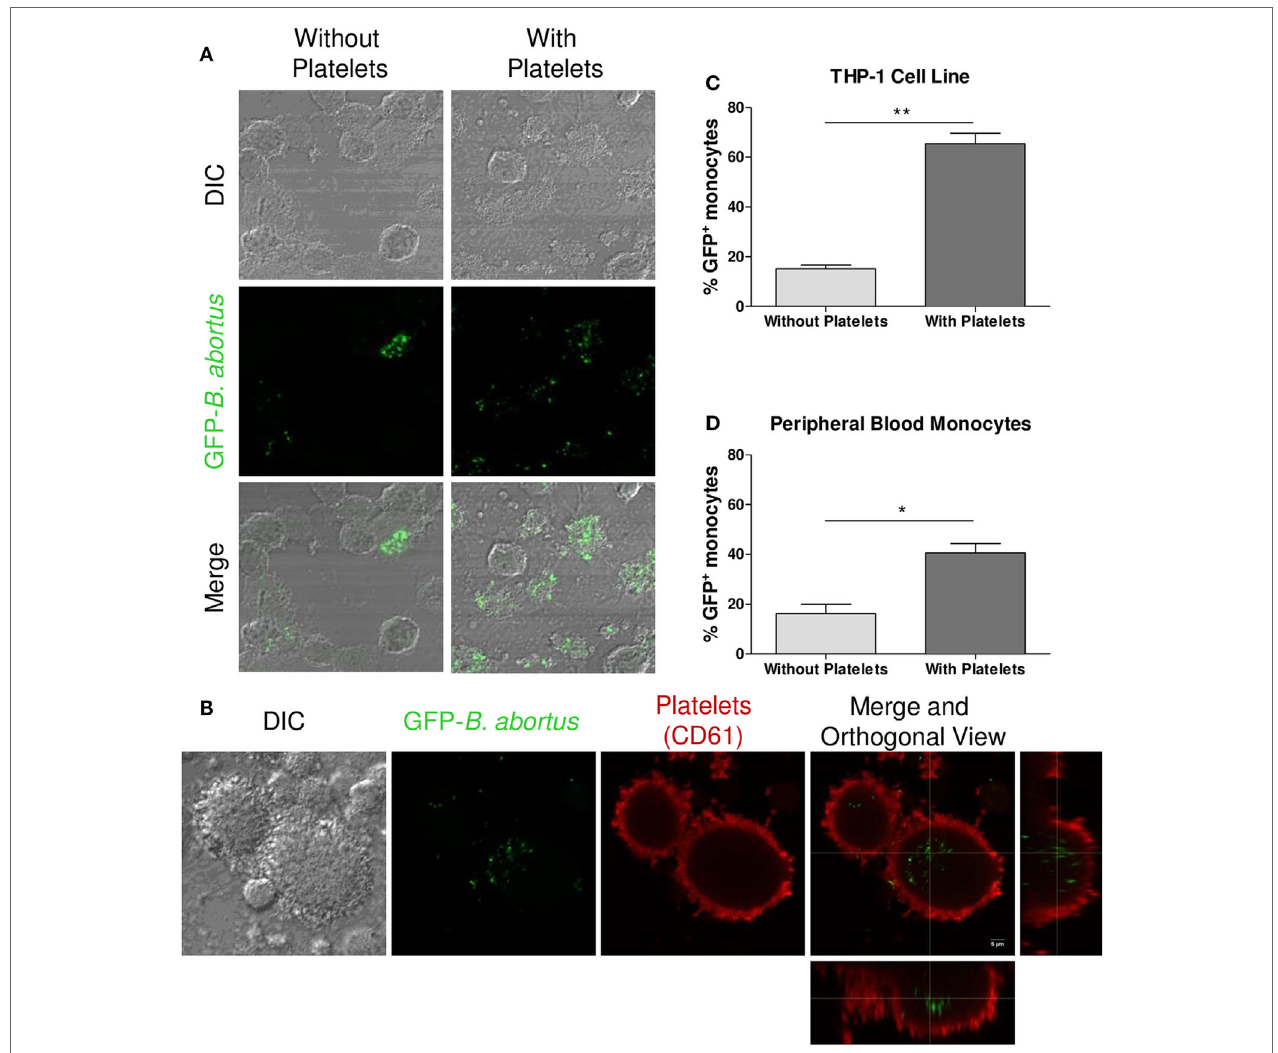
FigUre 2 | Platelets promote monocyte/macrophage invasion by Brucella abortus . (a) Confocal micrographs of THP-1 cells infected with green fluorescence protein (GFP)- B. abortus in presence or absence of platelets for 4 h. (B) Confocal micrographs of THP-1 cells infected with GFP- B. abortus in presence of platelets for 4 h. Platelets were stained with an anti-human CD61 primary Ab and Alexa-546-labeled secondary Ab (red). (c) Quantification of THP-1 cell invasion by B. abortus . (D) Quantification of peripheral blood-isolated human monocyte invasion by B. abortus . Data are expressed as the percentage of monocytes invaded (GFP-positive monocytes) ± SEM of three independent experiments. The number of cells counted per experimental group was 200. * P < 0.05; ** P < 0.01 vs. monocytes without platelets. THP-1:PTL: Ba